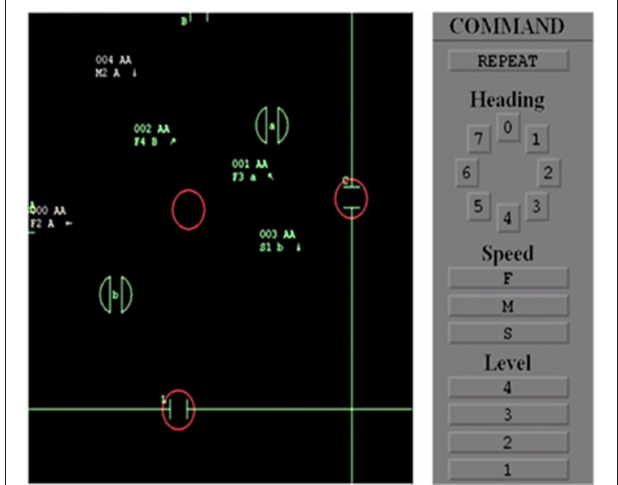
FIGURE 1 | The air traffic control task interface for C-Team. Control panel (the gray box on the right) with controls for heading direction, speed, and level of aircraft. The aircraft (represented by arrows), airports (represented by lowercase letters with two half circles), exits (represented by uppercase letters), and restricted areas (represented by red circles). White and green colors denote aircrafts that are in active and en route respectively.